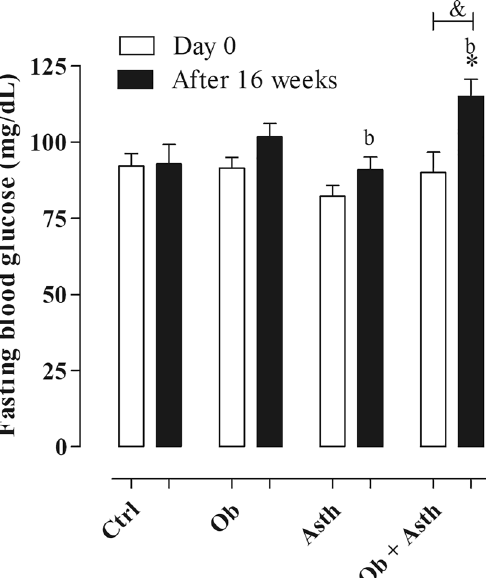
Figure 2. Fasting blood glucose of rats from the Ctrl, Ob, Asth and Ob + Asth. One-way ANOVA followed by Tukey’s posttest (n = 6). * p < 0.05 (Ctrl vs. Ob + Asth), b p < 0.05 (Asth vs. Ob + Asth), & p < 0.05 (Ob + Asth day 0 vs. Ob + Asth after 16